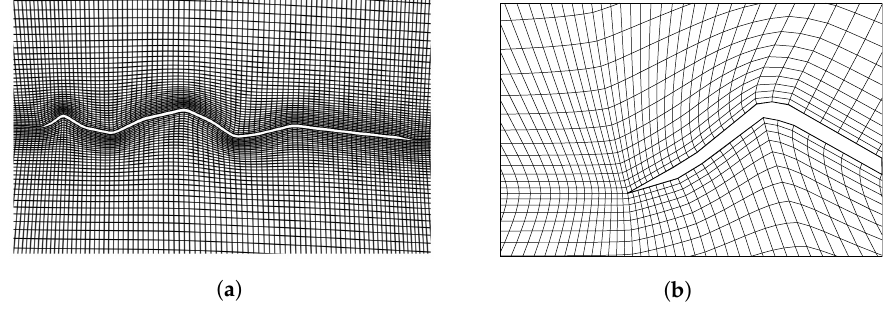
Figure 4. Computational grid: ( a ) corrugated airfoil; and ( b ) around leading edge.